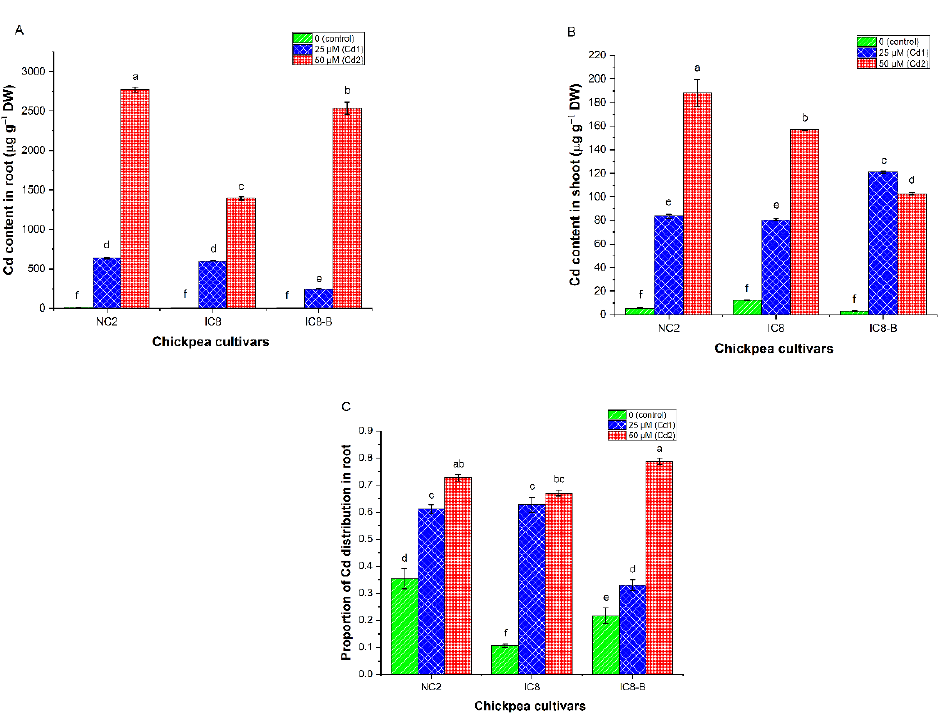
Figure 4. Cadmium content in the root ( A ), shoot ( B ), and distribution proportion in the root ( C ) of chickpea cultivars (NC2, IC8 and IC8-B) under various concentrations of Cd (0, 25 and 50 µM). The bars represent SE, n = 3. Columns with different characters are significantly different according to (DMRT) at p < 0.05.